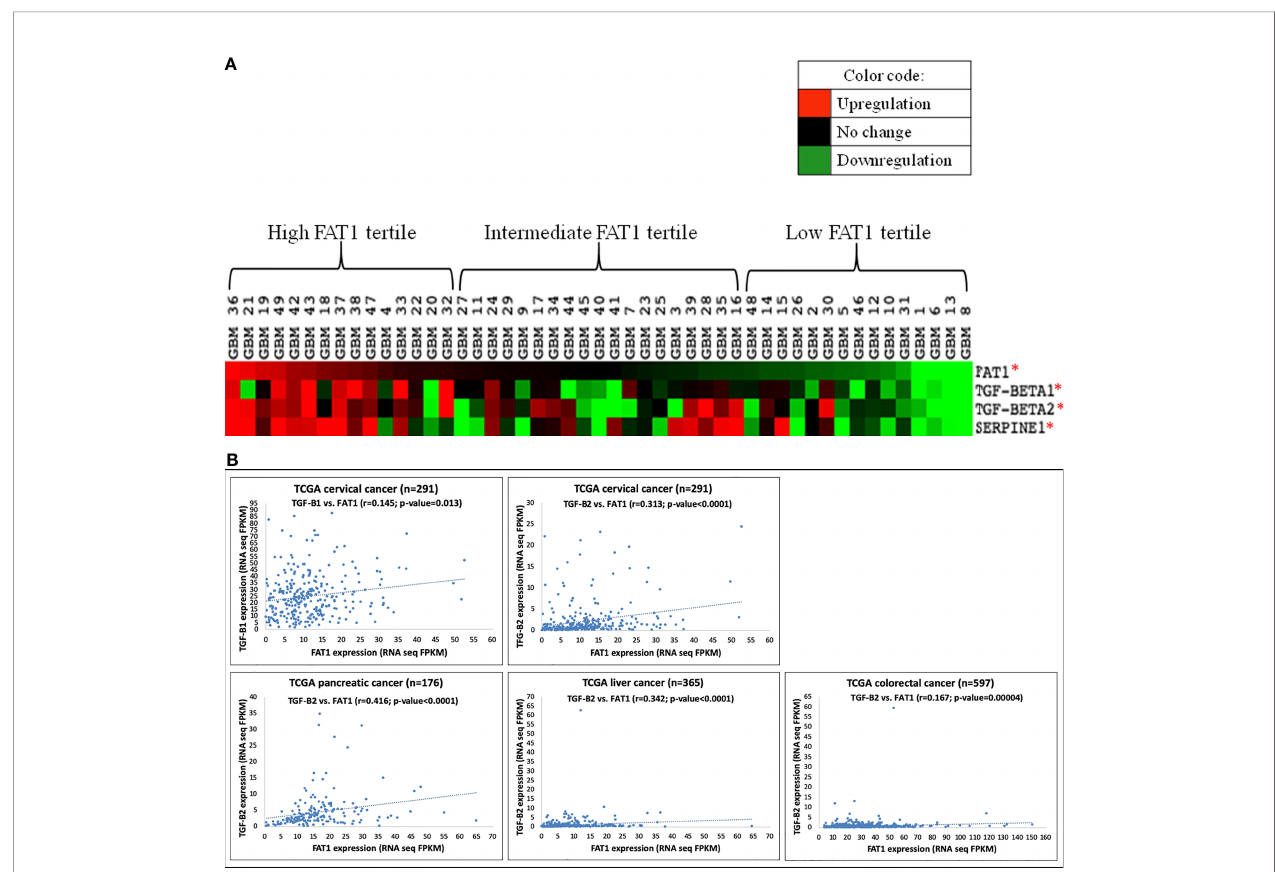
FIGURE 1 | (A) Heat map showing semisupervised gene clustering of TGF- b 1, TGF- b 2, and Serpine1 expression in 49 GBM tumors arranged in decreasing order of FAT1 expression. Gene expression values found signi fi cantly different across high (n = 15) and low (n = 15) FAT1 tertiles have been marked with an asterisk (*) indicating p-value ≤ 0.05. (B) Scatter plots showing a positive correlation of FAT1 expression with the expression of TGF- b 1 and TGF- b 2 in various types of cancers (cervical, pancreatic, liver, and colorectal cancers) as analyzed in TCGA cases. TCGA, The Cancer Genome Atlas; FPKM, fragments per kilobase per